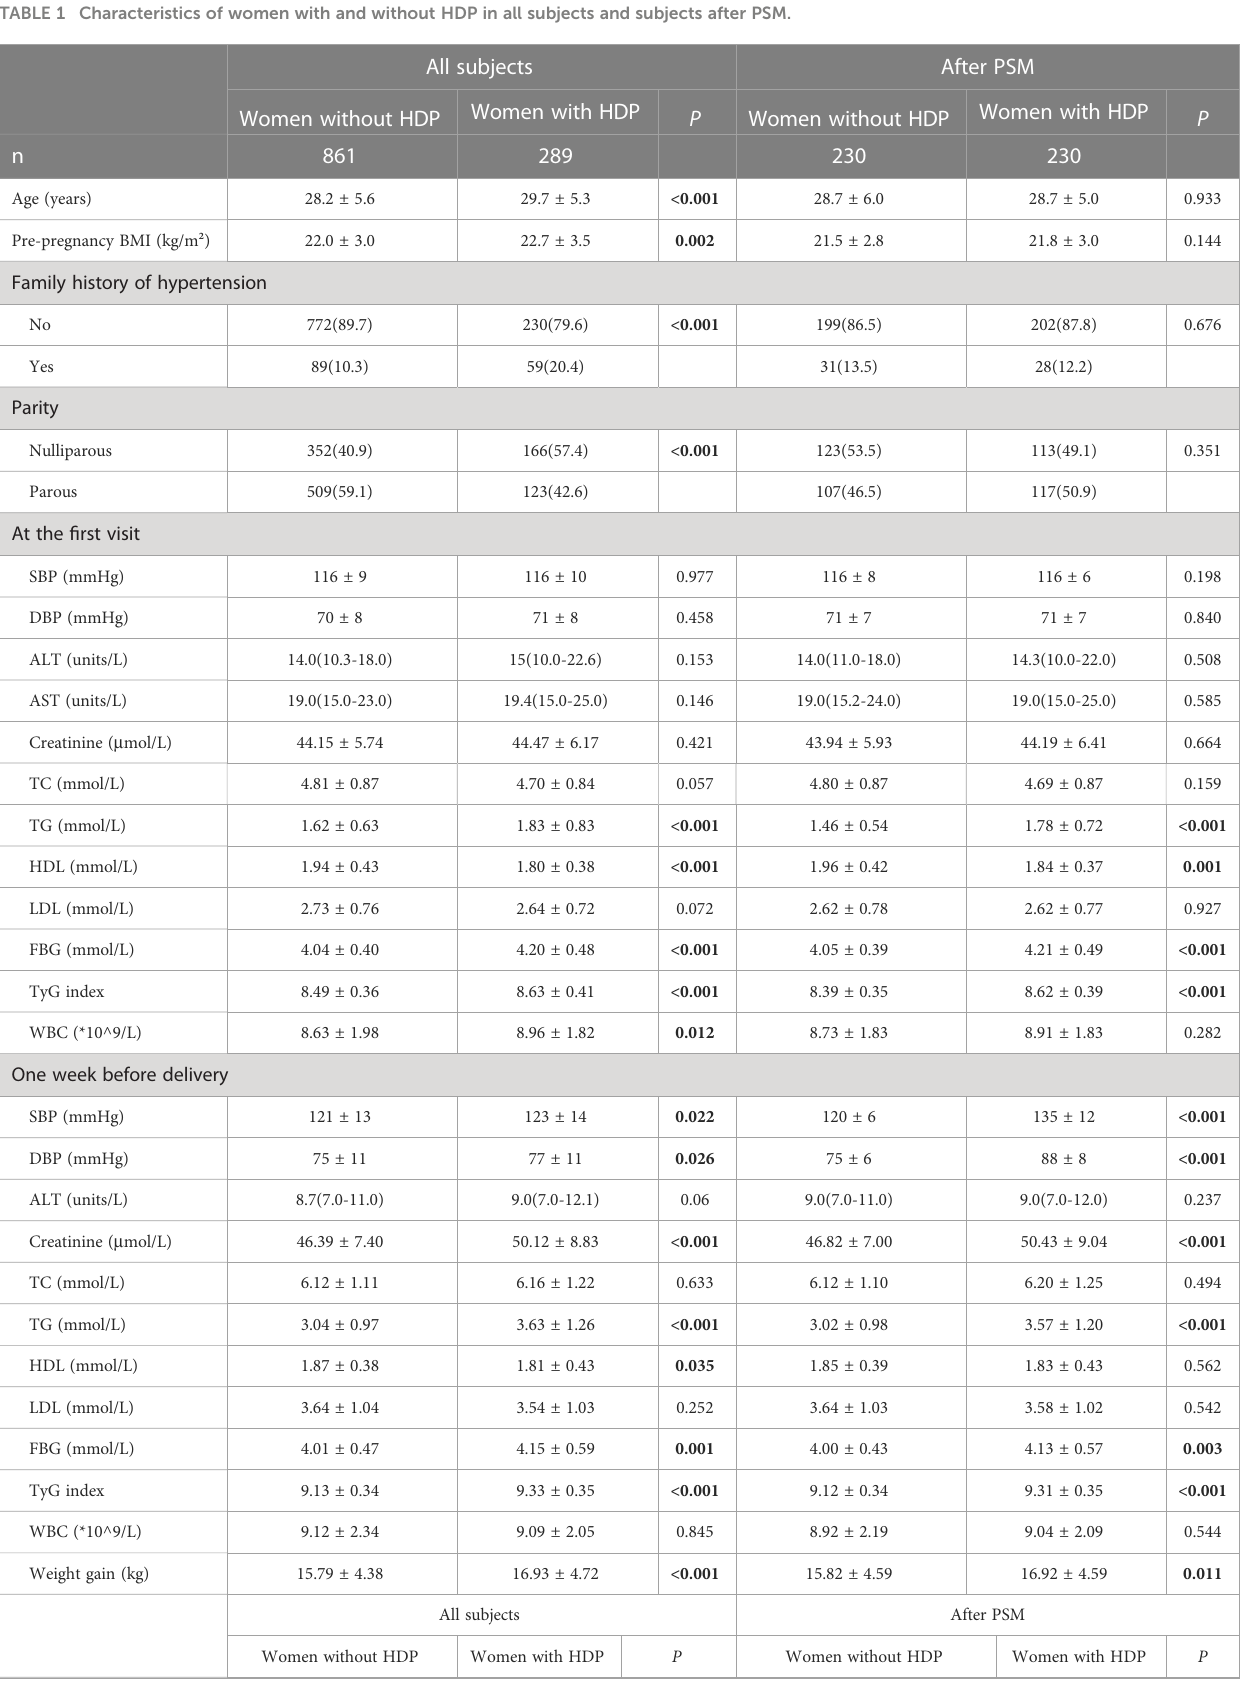
TABLE 1 Characteristics of women with and without HDP in all subjects and subjects after PSM. All subjects After